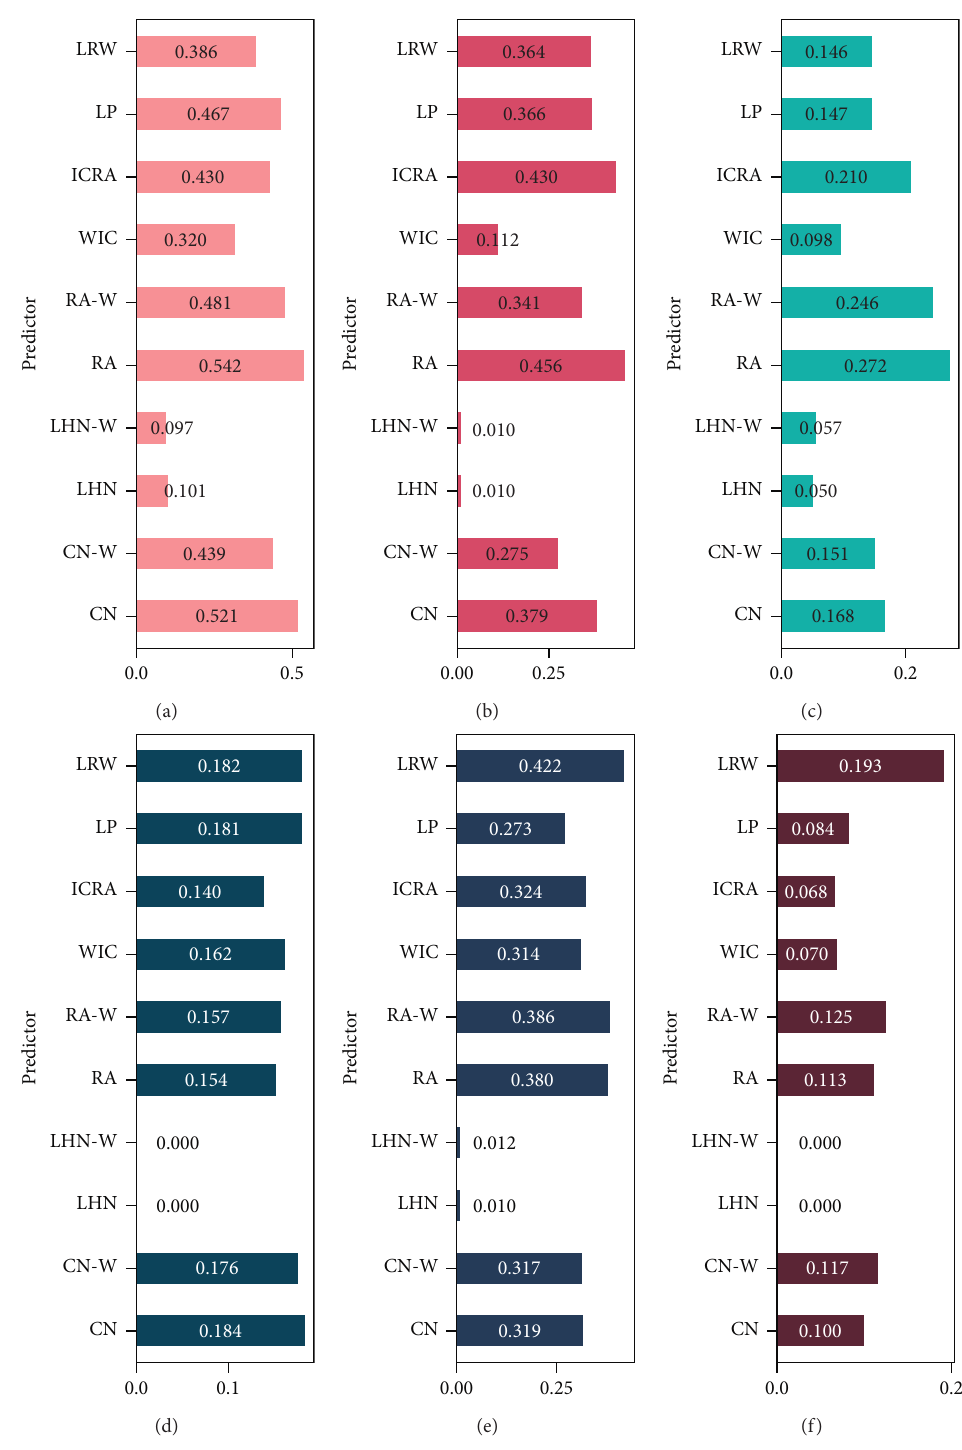
Figure 3: Accuracy of ten predictors quantified by precision on six networks. (a) Jazz. (b) USAir. (c) Metabolic. (d) PB. (e) Tvshow. (f) Yeast. Table 4: The correlation coefficient between W-index score and precision score and that of AUC score and precision score on six networks. Networks Jazz USAir Metabolic PB Tvshow Yeast W-precision 0.373 0.412 0.695 0.880 0.236 0.295 AUC-precision 0.491 0.601